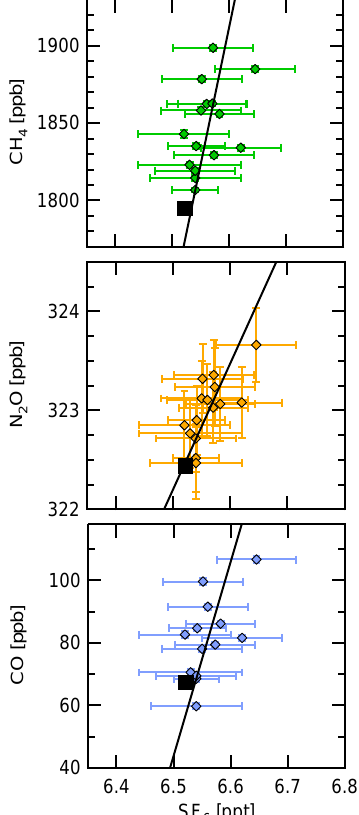
Fig. 10. Correlation of CH 4 , N 2 O, and CO with SF 6 in the mon- soon plume in September. The black lines result from a weighted orthogonal distance regression, the black squares indicate the back- ground mixing ratios (SF 6 interpolated from CARIBIC data, CH 4 and CO mean value, N 2 O median observed at MLO in September